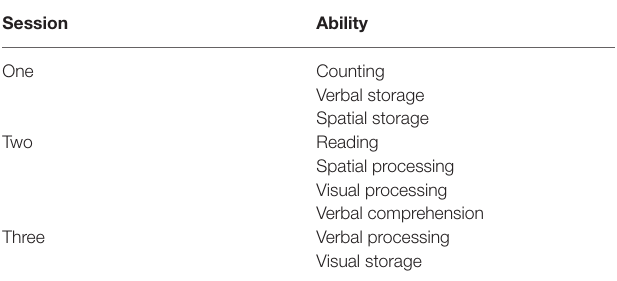
TABLE 2 | Sequence of tasks within each testing